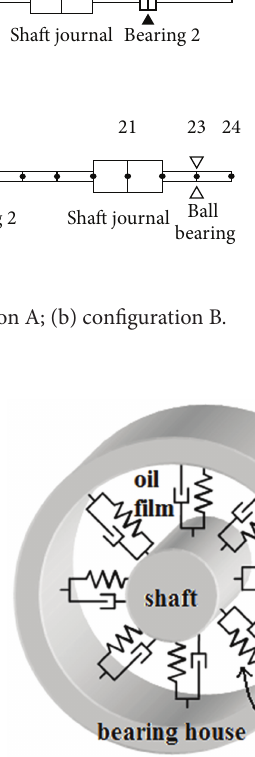
Figure 2: Model of the journal